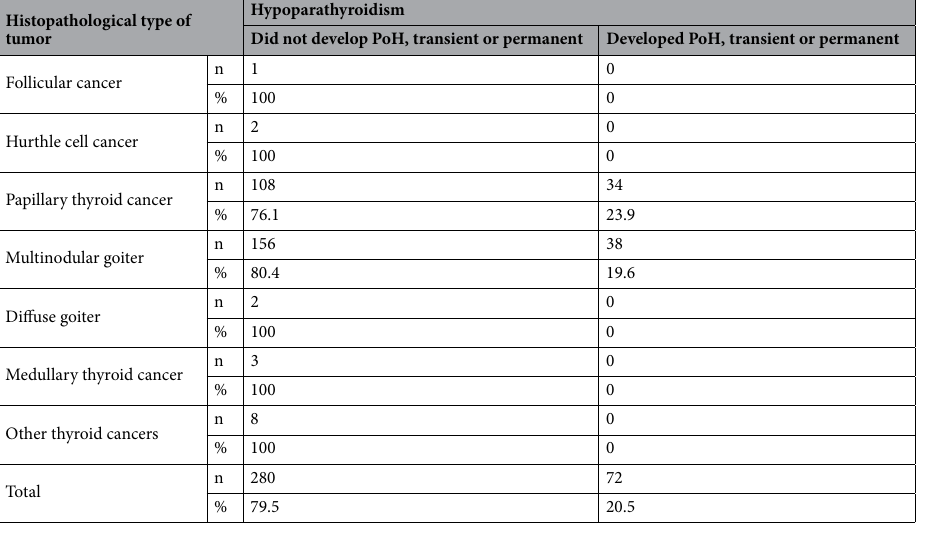
Table 3. Temporary hypoparathyroidism development according to the histopathological tumor type. n Number.